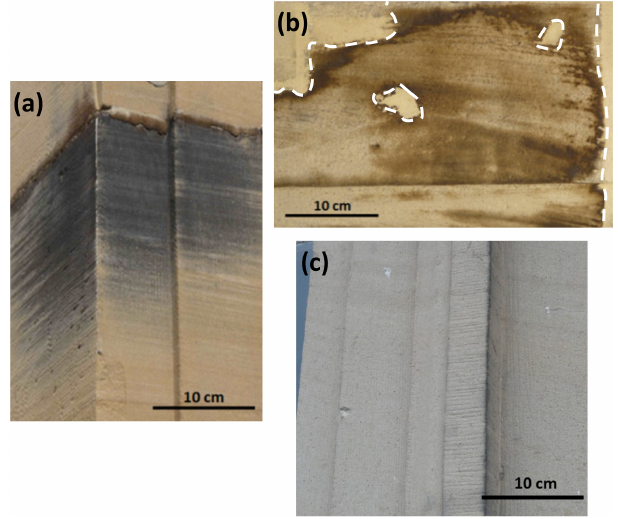
Figure 2. Macroscopic views of the extracted blocks. (a) L1: sand- stone with patina from an unburnt zone. (b) L2: sandstone with patina from a burnt and highly watered zone. Dotted white lines indicate the interface between L2 sandstone and mortar used for reparations and joints. (c) L4: patina-free sandstone from an un- burnt zone.